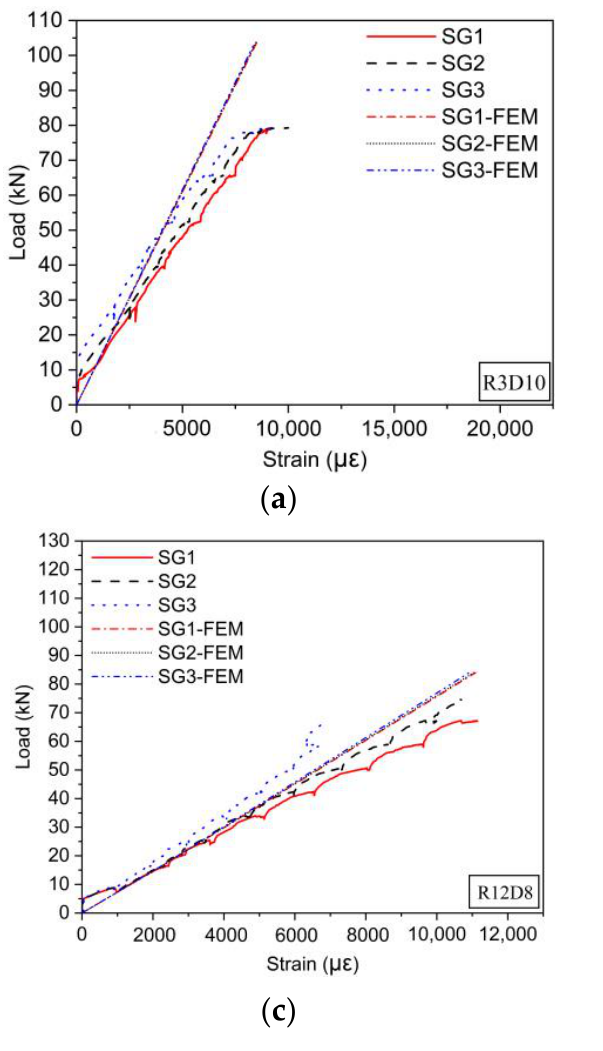
Figure 9. Load–strain curves of CFRP tendons: ( a ) R3D10; ( b ) R8D8; ( c ) R12D8; ( d ) R12D10.